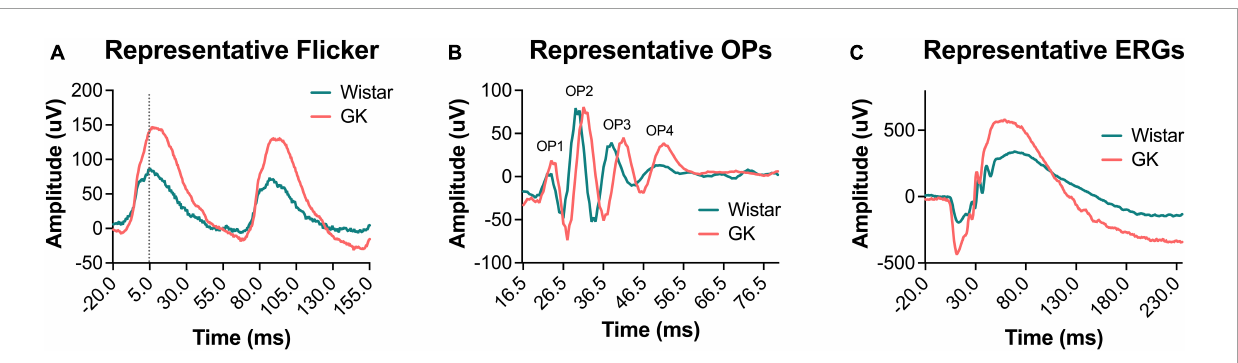
FIGURE2 Representative waveforms from GK rats showed delayed implicit times and increased amplitudes. Representative waveforms for light-adapted flicker ERG (A) , dark-adapted OPs (0.7 log cd s/m 2 ) (B) , and dark-adapted ERGs (0.7 log cd s/m 2 ) (C) at 2 months of